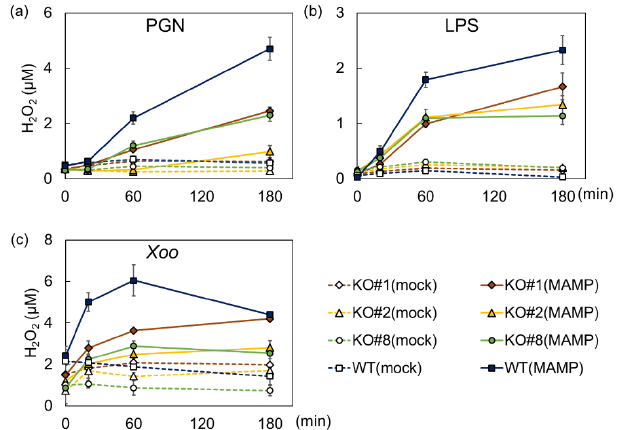
Figure 1. Knockouts of BSR1 impaired H 2 O 2 production in rice cell cultures treated with MAMPs. Suspension-cultured cells were treated with peptidoglycan ( a ), LPS ( b ), or an autoclaved suspension of Xanthomonas oryzae pv. oryzae ( Xoo ; c ). H 2 O 2 concentrations were measured before treatment and at 20, 60, and 180 min after treatment. Values are presented as the means ± standard deviations of three biological replicates. Experiments were conducted twice with similar results. PGN, peptidoglycan; LPS, lipopolysaccharide; KO, knockout line; KO#1, bsr1-1 #13-1; KO#2, bsr1-2 #16-2; KO#8, bsr1-8 #5-1; WT, wild-type; MAMPs, microbe-associated molecular patterns; BSR1, BROAD-SPECTRUM RESISTANCE 1. The statistical analysis was performed as shown in Supplementary Materials Table